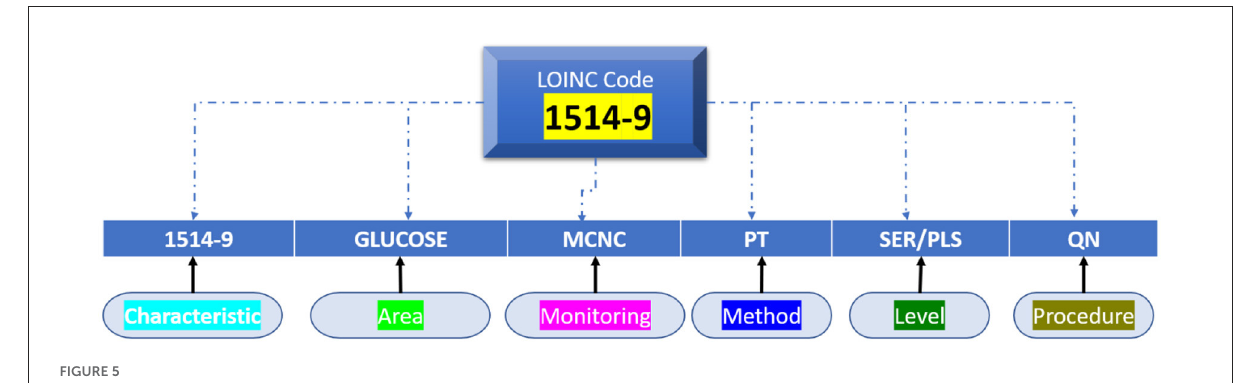
FIGURE5 Quantitative measure of LONIC name and